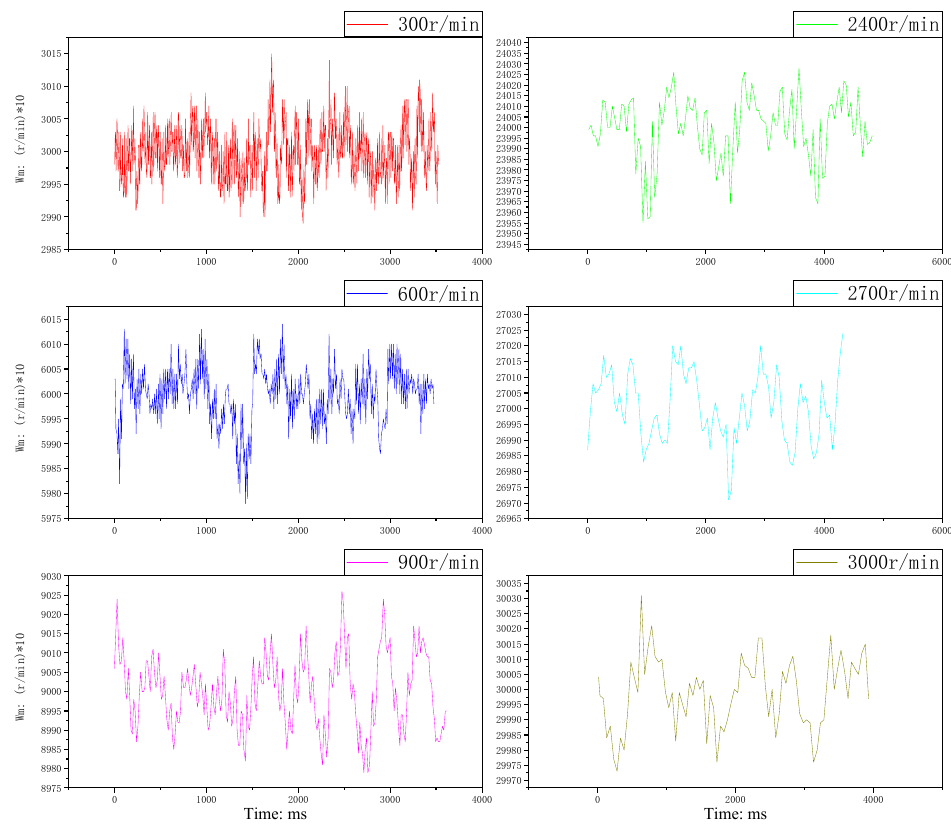
Figure 13. Constant pressure (10 MPa)–variable SM speed fluctuation graph. Table 4. Rotation speed–pressure–standard deviation table. Rotating Speed (r/min)